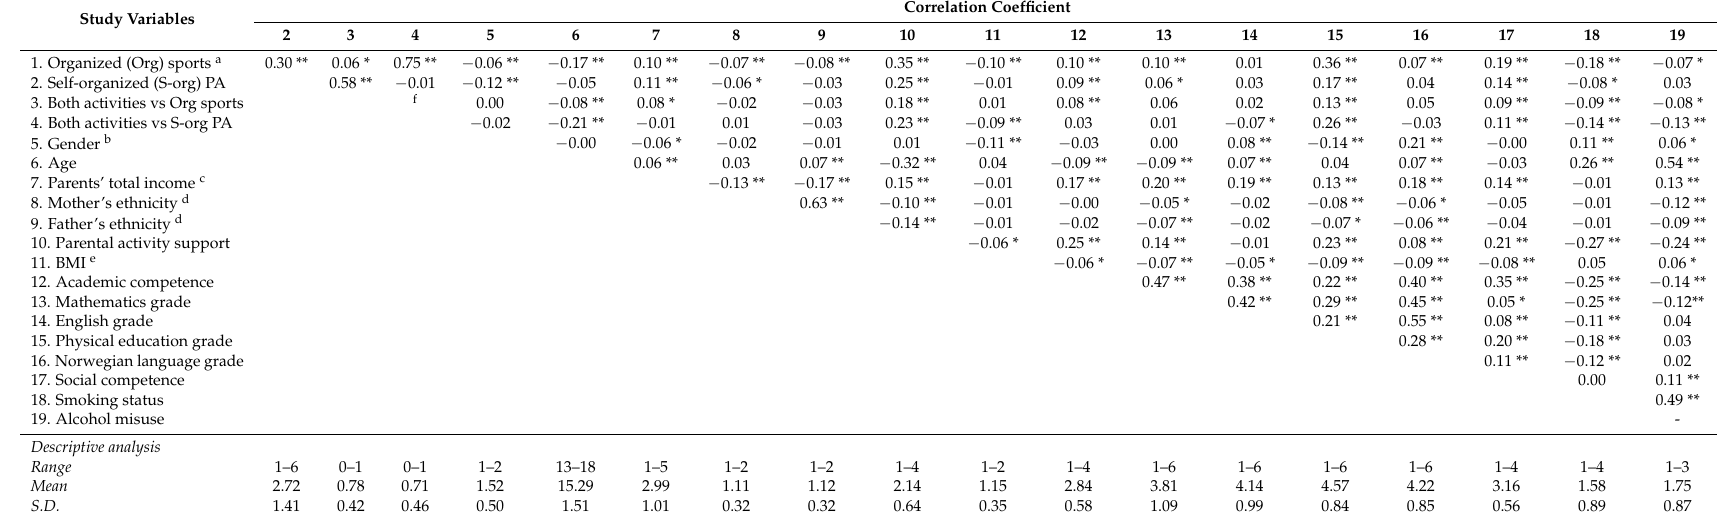
Table 2. Descriptive analysis and correlation analyses of study variables with organized sports and self-organized physical